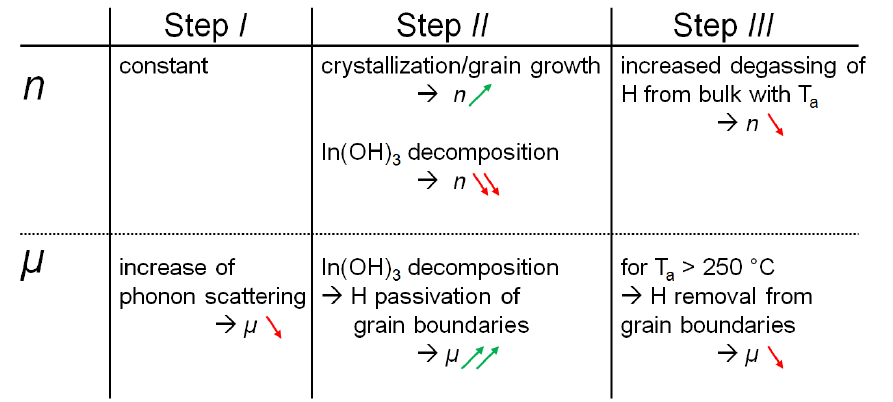
Figure 9. Summary of a model explanation for the changes in carrier concentration and mobility during the vacuum annealing of In